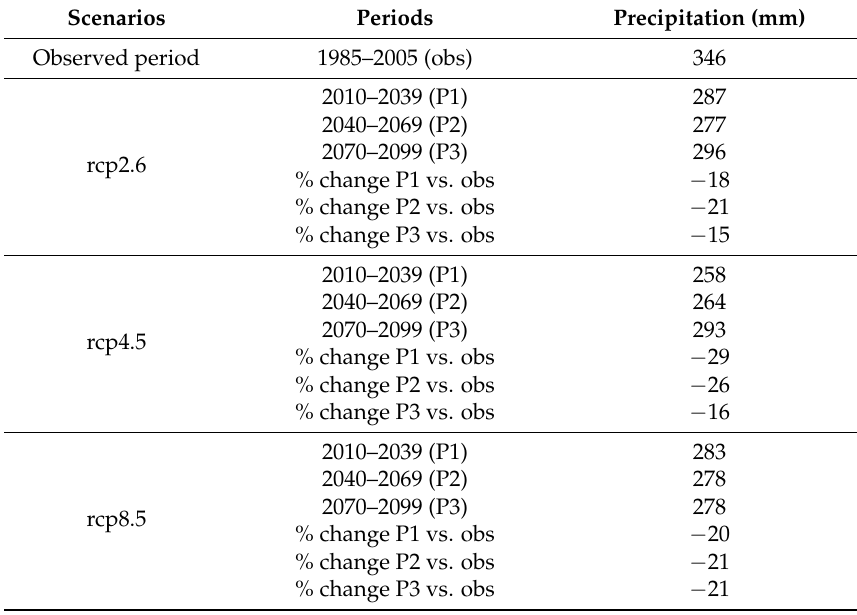
Table 4. Results of the annual precipitation predictions of the CanESM2 scenarios for the periods